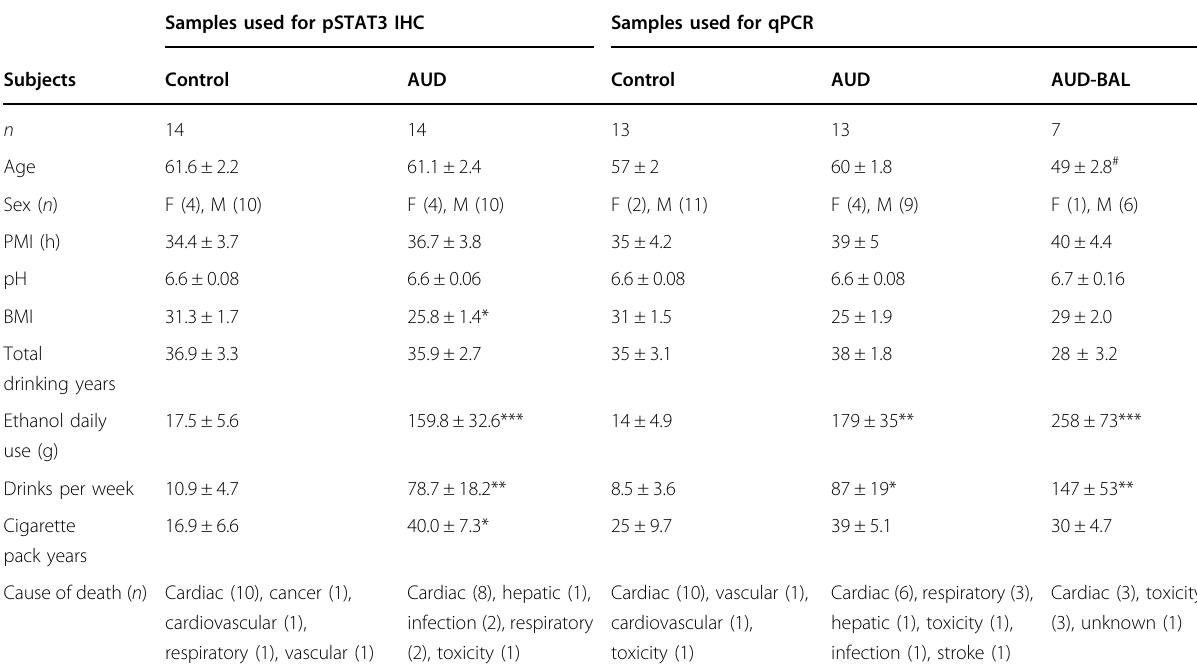
Table 1 Demographic characteristics of control and alcohol use disorder (AUD) subjects. Samples used for pSTAT3 IHC Samples used for